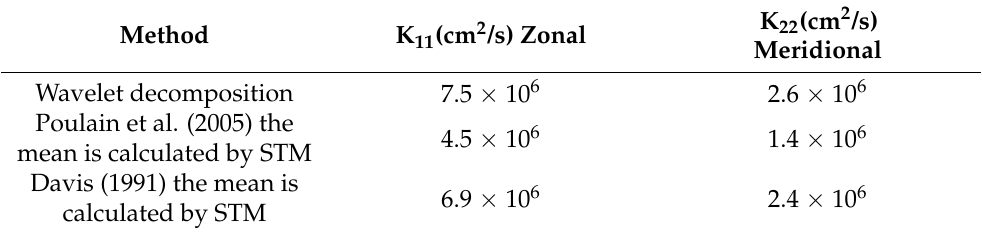
Table 1. Comparison of diffusivity for Black Sea estimates using different mean circulation.